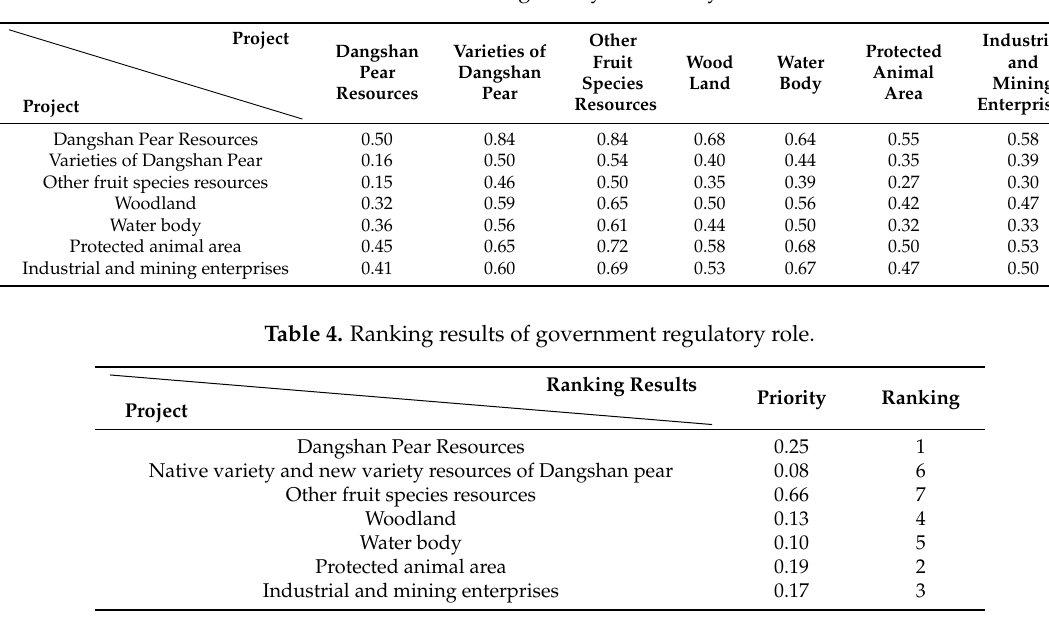
Table 3. Government regulatory role survey results.